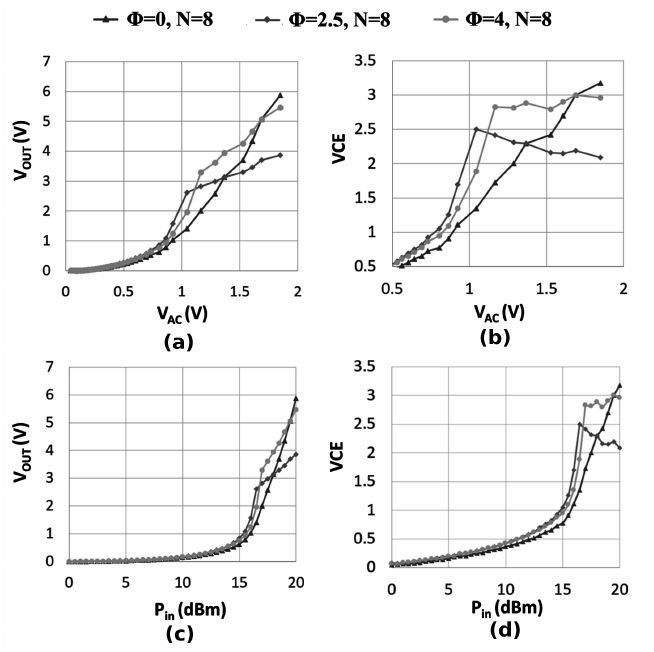
Figure 14. Measured output voltage and VCE versus the input power ( P in ) and the peak-to-peak input voltage ( V AC ) for different voltage multiplier topologies. ( R OUT = 3.9 M Ω , C = 470 nF, f = 100